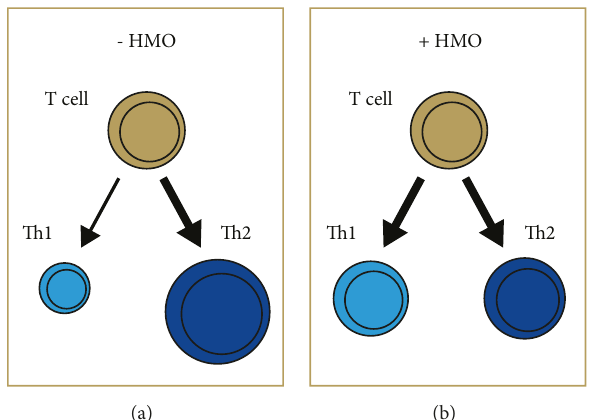
Figure 6: T-cell response in (a) absence of HMOs and (b) presence of HMOs. The modulation of the immune system by the HMOs leads to a more balanced T-cell